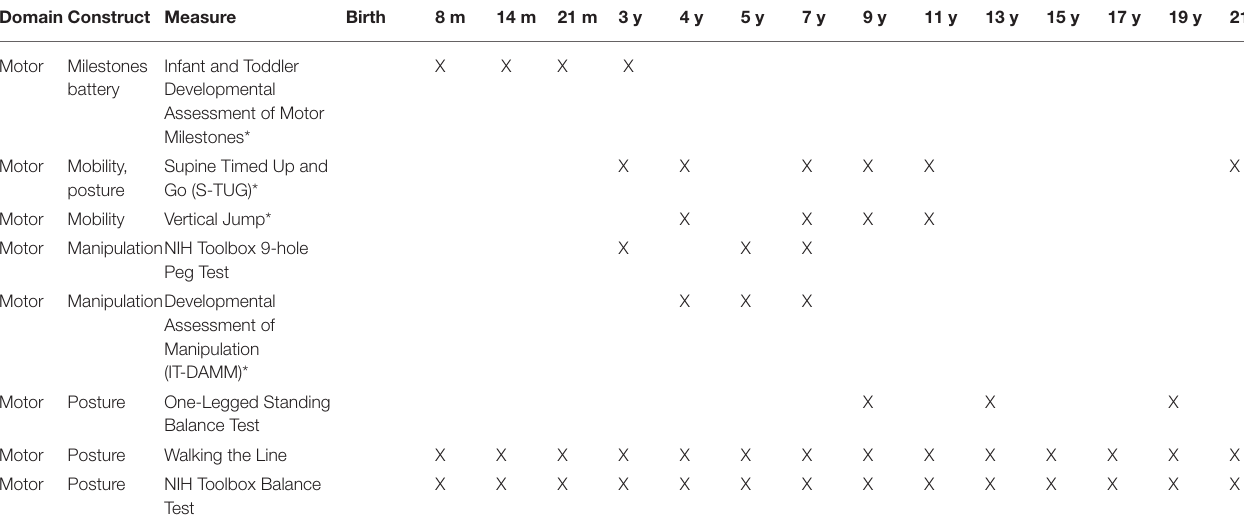
TABLE 1 | Recommended motor assessments and age for assessment. Domain Construct